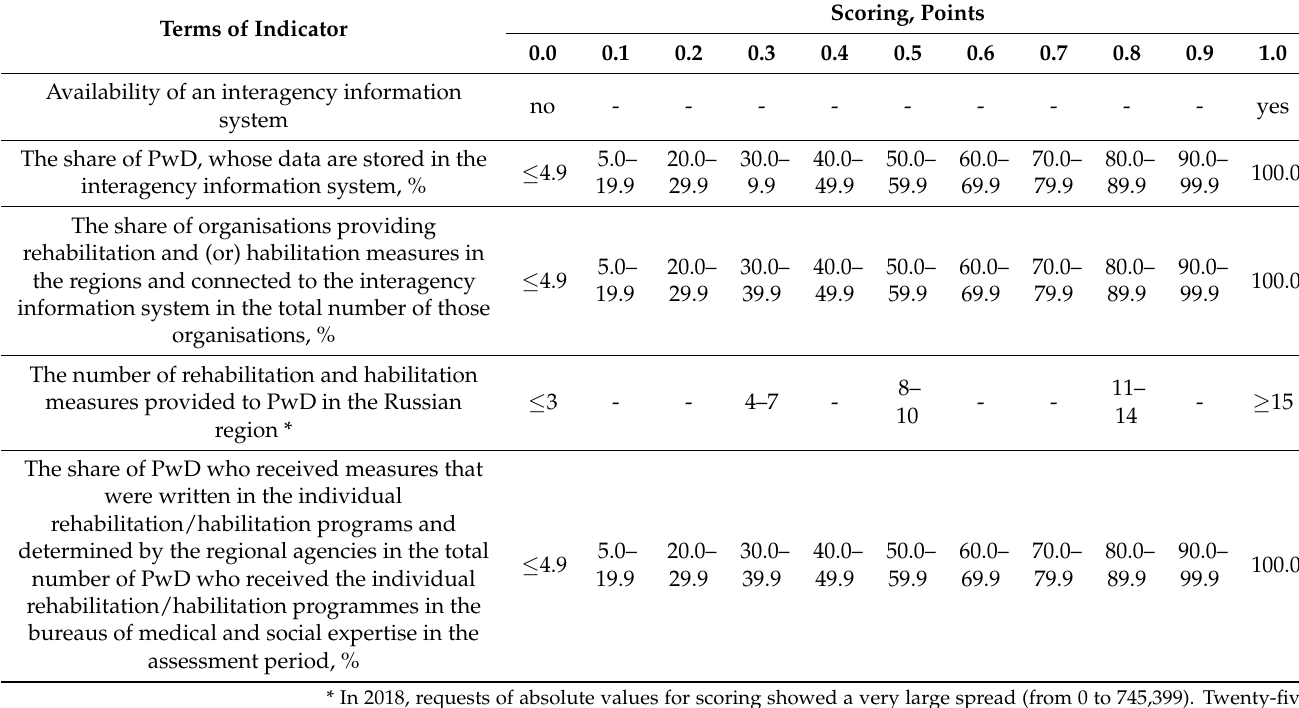
Table A4. Scoring of the indicator “The staffing of organisations providing rehabilitation and/or habilitation services with